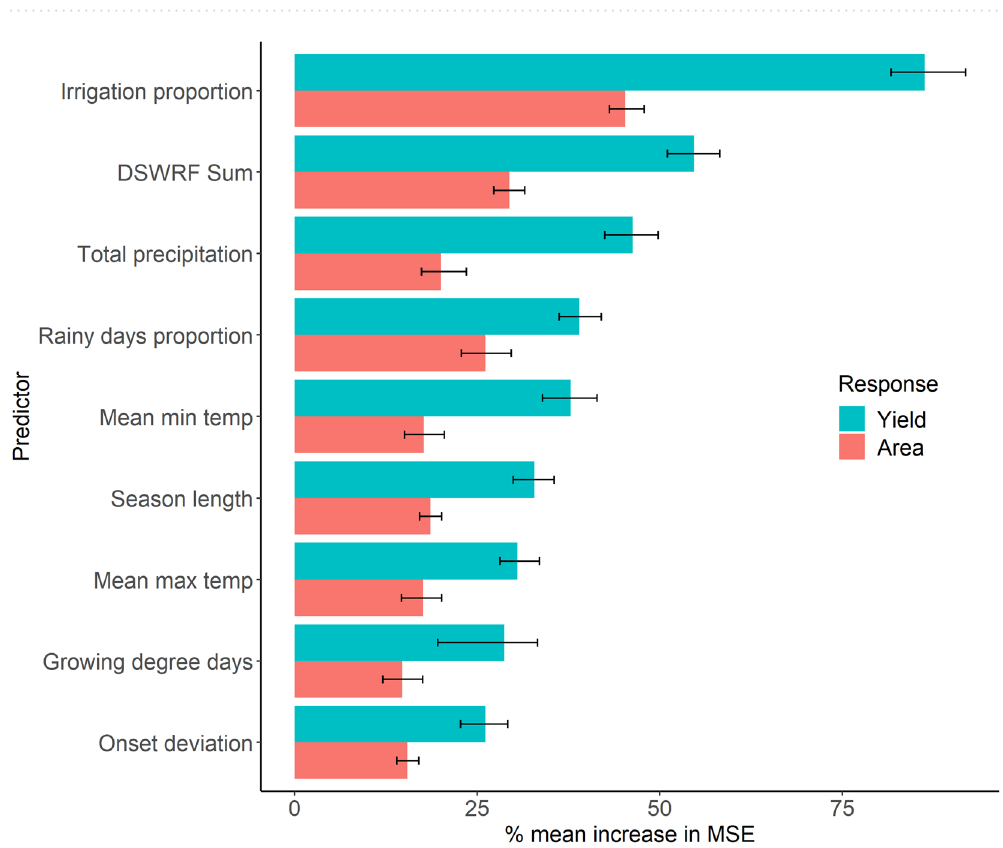
Figure 3. Variable importance plot from the random forest models calculated as percentage increase in mean- square error (MSE). Main bars represent mean value from 100 runs, inset whiskers represent 95th percentile of